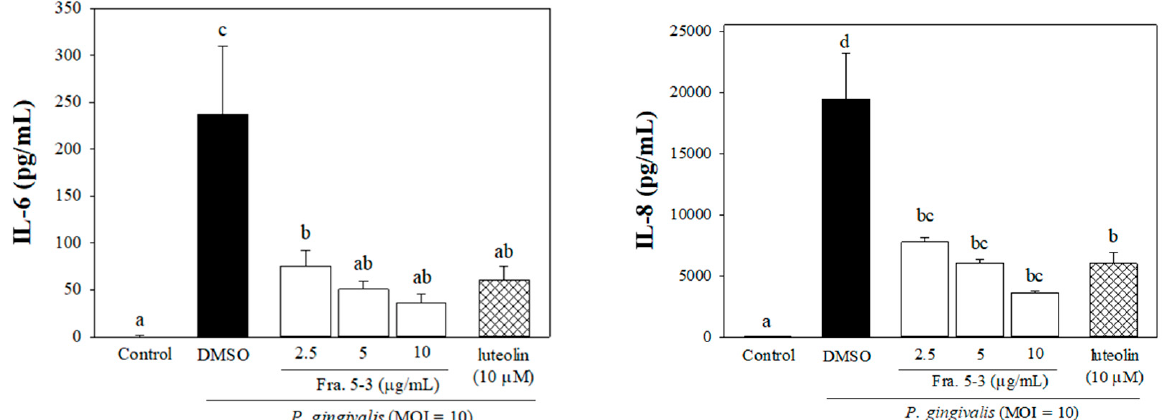
Figure 2. Effects of sub-fraction (Fra. 5-3) isolated from wild bitter melon leaf extract on P. gingivalis -induced pro- inflammatory cytokine productions in human monocytic THP-1 cells. Cells were incubated with 0.1% ( v / v ) DMSO (as a vehicle control), or co-cultured with P. gingivalis (M.O.I. = 10) and different concentrations of sub-fraction 5-3 (2.5, 5 or 10 µ g/mL) for 24 h. The cell-free culture supernatants were subsequently collected and analyzed for the content of IL-8 and IL-6. Experiments were performed three times in triplicate. Each value represents the mean ± SD. Values with different letters are significantly different at p < 0.05.